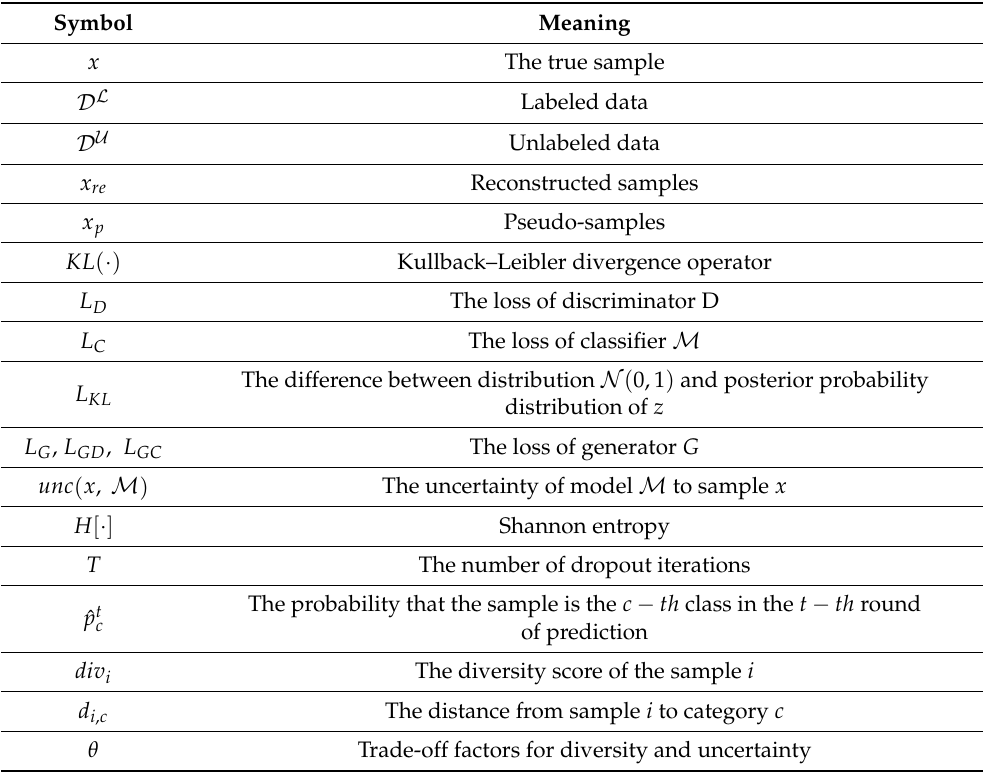
Table 1. Partial abbreviation vocabulary and basic symbols interpretation